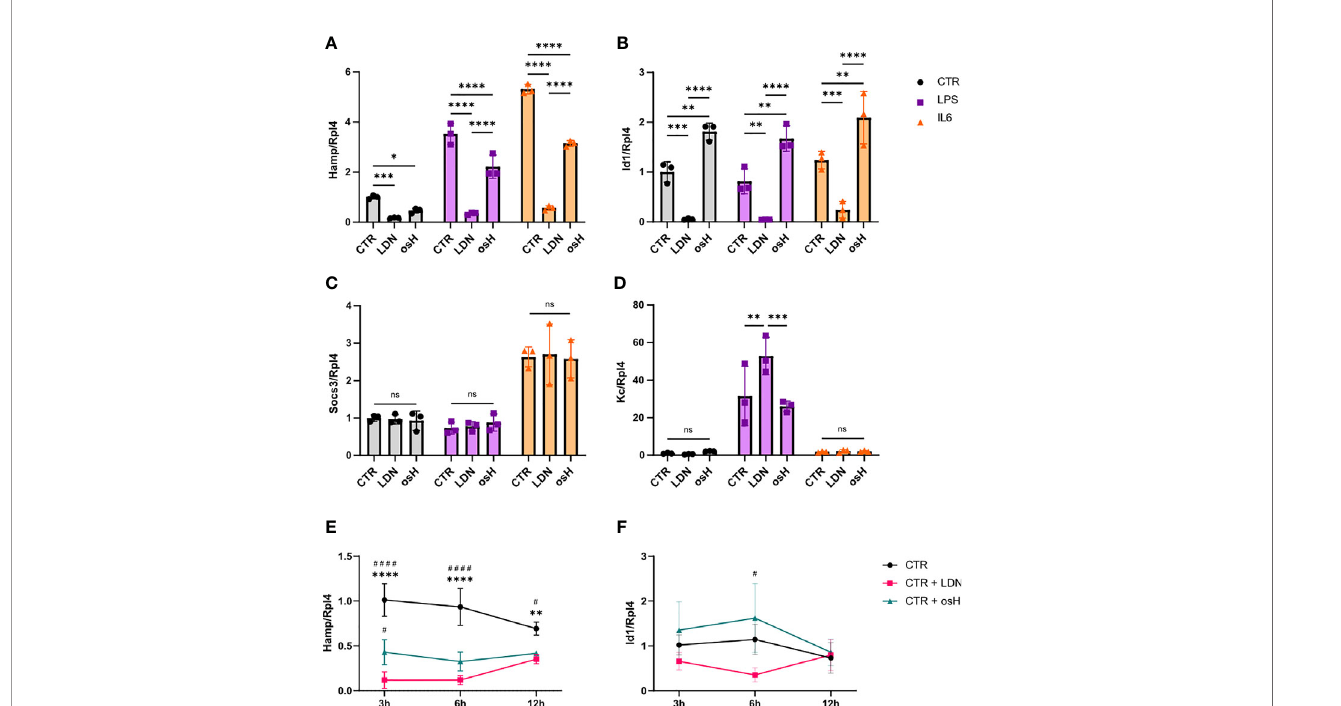
FIGURE 1 | LDN-193189 and oversulfated heparins inhibit hepcidin expression in vitro . Relative mRNA expression of genes of interest in FL83B hepatocytes treated with various stimuli and inhibitors. Ribosomal Protein L4 ( Rpl4) was used as a reference gene. Cells were incubated for 6h with either 500nM LDN-193189 (LDN) or with 3,6µg/ml of oversulfated heparins (osH). To simulate in fl ammatory conditions, cells were treated with 10ng/ml lipopolysaccharide (LPS) alone or together with one of the inhibitors or with 100ng/ml interleukin-6 (IL6) alone or together with one of the inhibitors. For this setup, the gene expression of (A) hepcidin antimicrobial peptide (Hamp) (B) Inhibitor of DNA binding 1 ( Id1) , (C) suppressor of cytokine signaling 3 ( Socs3) and (D) the murine homologue to IL8 (Kc) was determined. (E) Time course experiment with FL83B cells for Hamp expression and (F) Id1 gene expression. (A – F) n = 3 per group. For (A – D) , only the differences between CTR, LDN and osH were calculated. For more than two groups a one-way ANOVA was performed. *p < 0.05, **p < 0.01, ***p < 0.001, ****p < 0.0001. ns, no signi fi cance of differences. For (E, F) , # signi fi cant different from LDN treated cells, # p < 0.05, #### p < 0.0001; *signi fi cant different from osH treated cells, **p < 0.01, ****p <